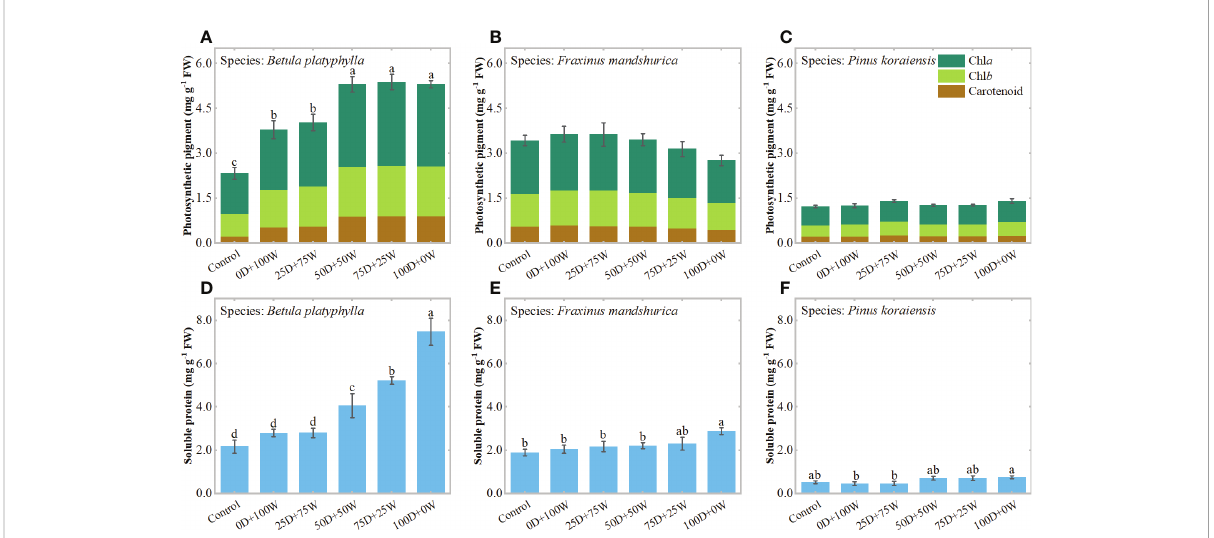
FIGURE 4 Concentrations of photosynthetic pigment (mg g -1 FW, A – C ) and soluble protein (mg g -1 FW, D-F ) in leaves of three species affected by six canopy nitrogen (N) application treatments for 32 days. N application treatments included a control (no application of N) and fi ve types of N deposition with dry to wet ratios of 0:100 (0D+100W), 25:75 (25D+75W), 50:50 (50D+50W), 75:25 (75D+25W) and 100:0 (100D+0W), respectively. Error bars indicate the standard error of the mean of chlorophyll ( a + b ) concentration and soluble protein concentration ( n = 5). Different letters above the error bar represent signi fi cant differences among six treatments ( P < 0.05) according to the least signi fi cant difference